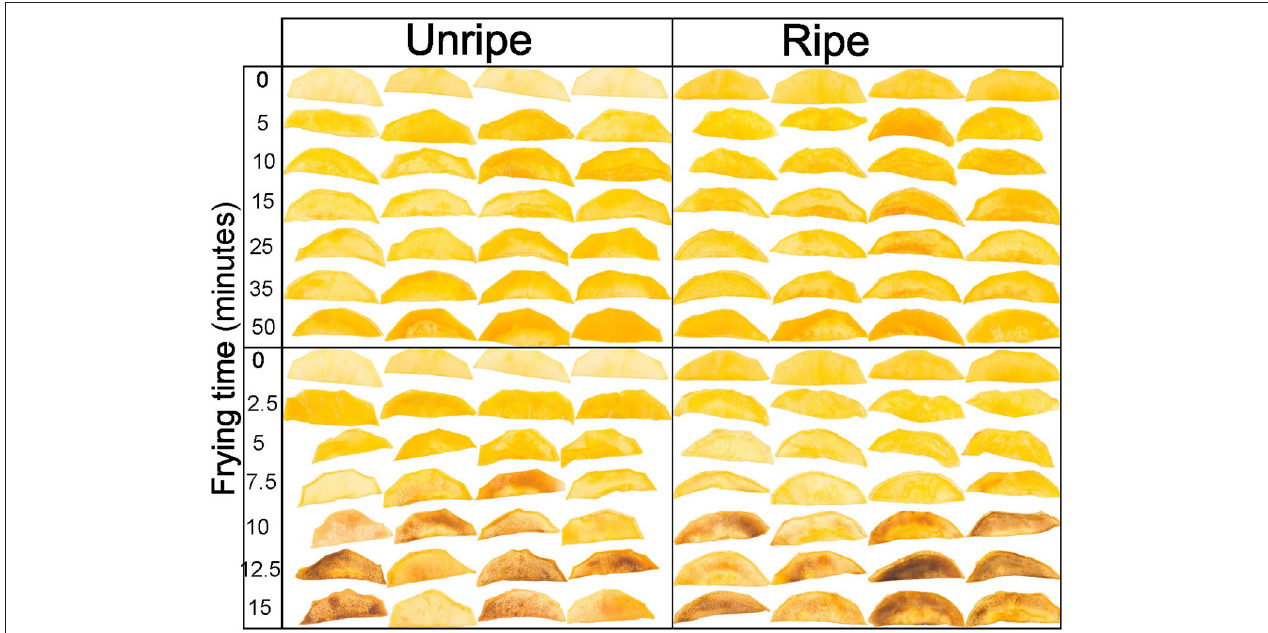
FIGURE 4 | Unripe (left) and ripe (right) mango slices vacuum fried at 90 (top) and 120 ◦ C (bottom) for different times.